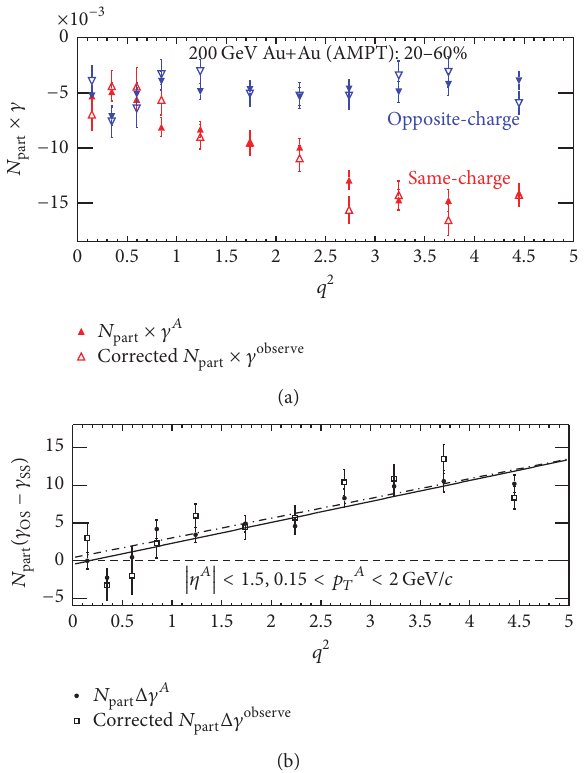
× 𝛾 (a) and 𝑁 Δ𝛾 (b) as functions of 𝑞 2 , from Figure 19: 𝑁 part part AMPT simulations [51]. The solid (dashed) line in (b) is a linear fit of the full (open) data